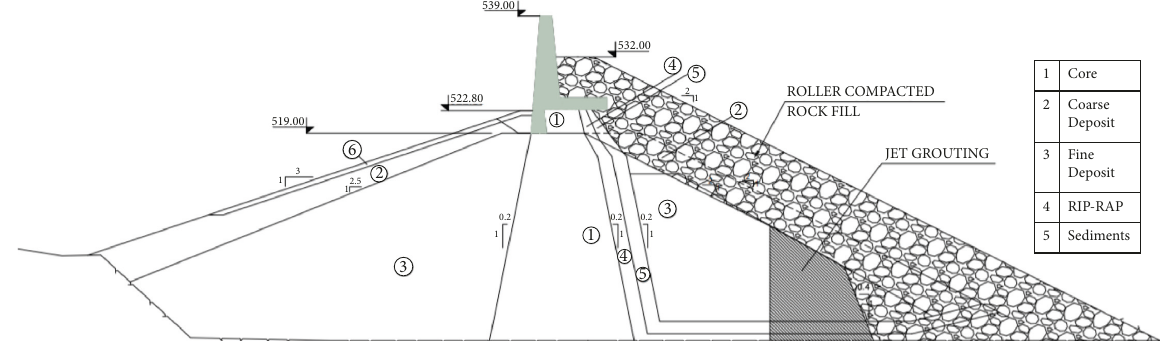
Figure 3: Raising of the wing embankment with reinforced concrete structure and roller-compacted rockfill part of Wala dam (after JVA, 2015a).